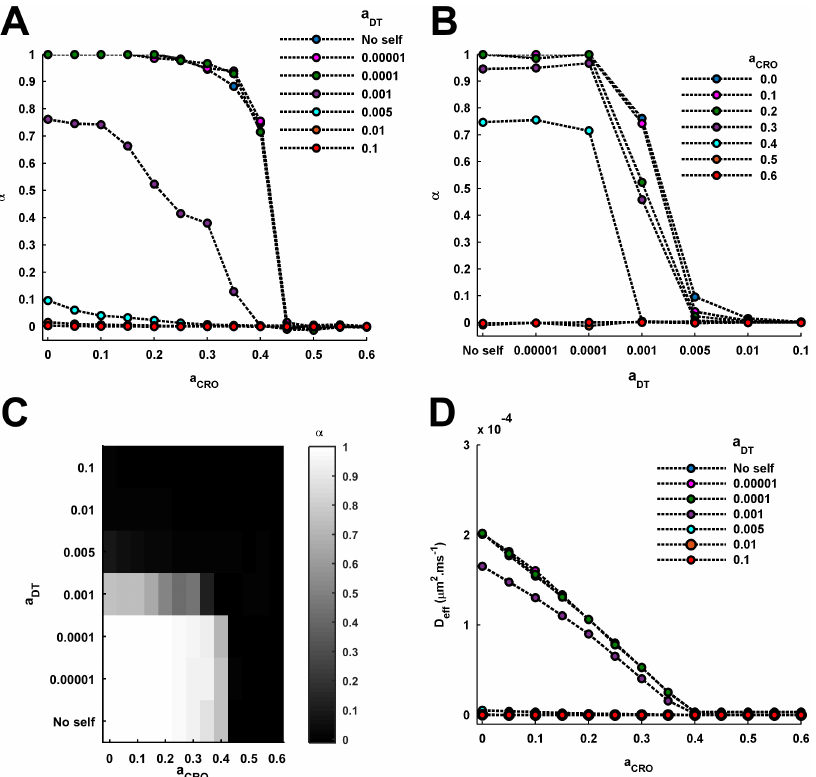
Fig 4. Effect of densities of CROs and DTs on the anomalousity and effective diffusion coefficient of tracer diffusion. Anomalousity of tracer diffusion is characterized through the anomalous exponent, α , of the diffusion, which is computed from the log-log profiles of the temporal evolution of MSD. α = 1 is associated with perfectly normal diffusion. Lower is the α , higher is the anomalousity of tracer diffusion. (A) The variation in α across increasing CRO density under different self-crowding conditions is shown. It is apparent that for lower DT densities, the profile of α exhibit a switch-like behaviour where the anomalousity steeply rises beyond a certain high level of a CRO (i.e. 0.4 here) and leads to the strong sub-diffusion or confinement of the diffusing tracers. However, very high levels of a DT consistently exhibit strong anomalous sub-diffusion regardless of the a CRO . (B) The variation in α across increasing a DT under different conditions of a CRO is shown. For lower a CRO , the profiles demonstrate a switch-like behaviour across increasing a DT and there occurs a sudden transition to strongly anomalous diffusion beyond a DT = 0.001. Increase in a appears to accentuate the sharpness of the transition. However, for very high a , the tracer diffusion CRO CRO is strongly anomalous regardless of the a . (C) The effects of varying a and a on the anomalousity of tracer DT CRO DT diffusion are collectively summarized in the gray-scaled heat-map and is derived from the previous observations made in (A) and (B). It clearly shows that both high CRO density and/or high DT density may lead to strongly anomalous sub-diffusion and trapping of tracers. (D) The variation in effective diffusion coefficient, D eff , of tracer diffusion across increasing CRO density under different self-crowding conditions is shown. For the lower values of a and the no-self- DT crowding condition, increase in a CRO leads to a consistent decrease in the D eff . Moreover, their profiles of D eff are highly overlapping and fairly identical. With increase in a , the profile shifts to lower levels, such that very high a is DT DT associated with almost negligible D and, in concordance with α , indicates severely hampered and confined tracer eff mobility, regardless of a CRO . Notably, at a CRO = 0, D eff of tracer diffusion for no-self-crowding conditions and a DT (cid:20) 0.0001 is equivalent to the effective free diffusion coefficient of AMPARs (0.2 nm 2 . μs −1 ) in the extrasynaptic membrane of excitatory